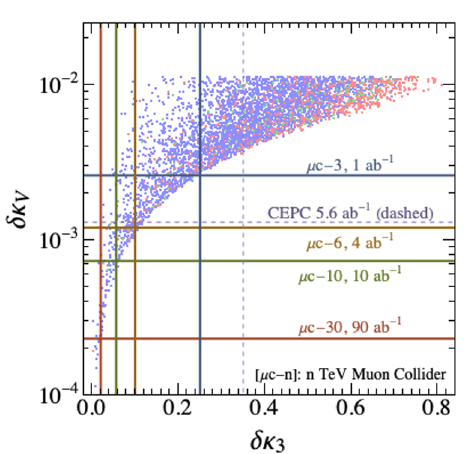
Figure 5 . Indirect limits from the measurements of the Higgs couplings. The scatter points are the FOEWPT data, in which red, green and blue colors represent SNR ∈ [50 , + ∞ ) , [10 , 50) and [0 , 10) , respectively. The colored vertical and horizontal lines are the projections of different setups of muon √ colliders. The projections of CEPC ( s = 250 GeV) are also shown in dashed lines for